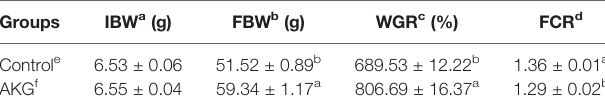
TABLE 3 | The effects of AKG on the growth and feed utilization of Songpu mirror carp ( Cyprinus carpio ). Groups